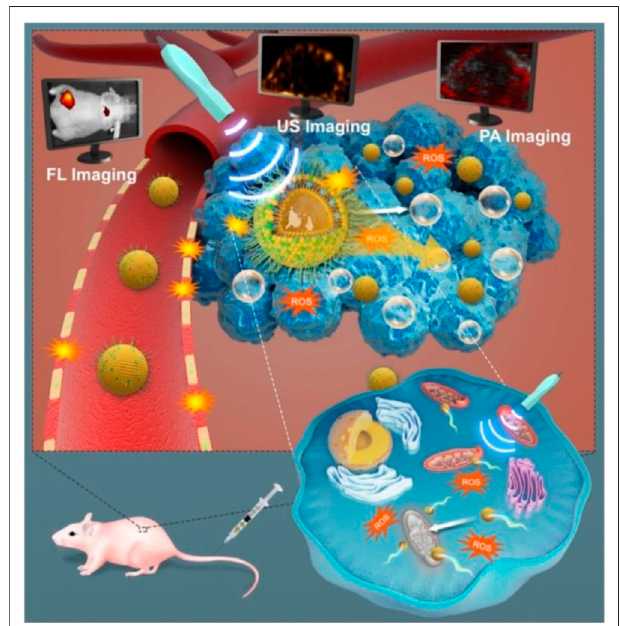
FIGURE 8 | As-synthesized US-responsive NDs for ef fi cient SDT which include deep penetration, tumor cell- or mitochondria-targeting ability, ADV, and guidance or monitoring by multimodal (US, PA, and FL) imaging (Zhang et al.,